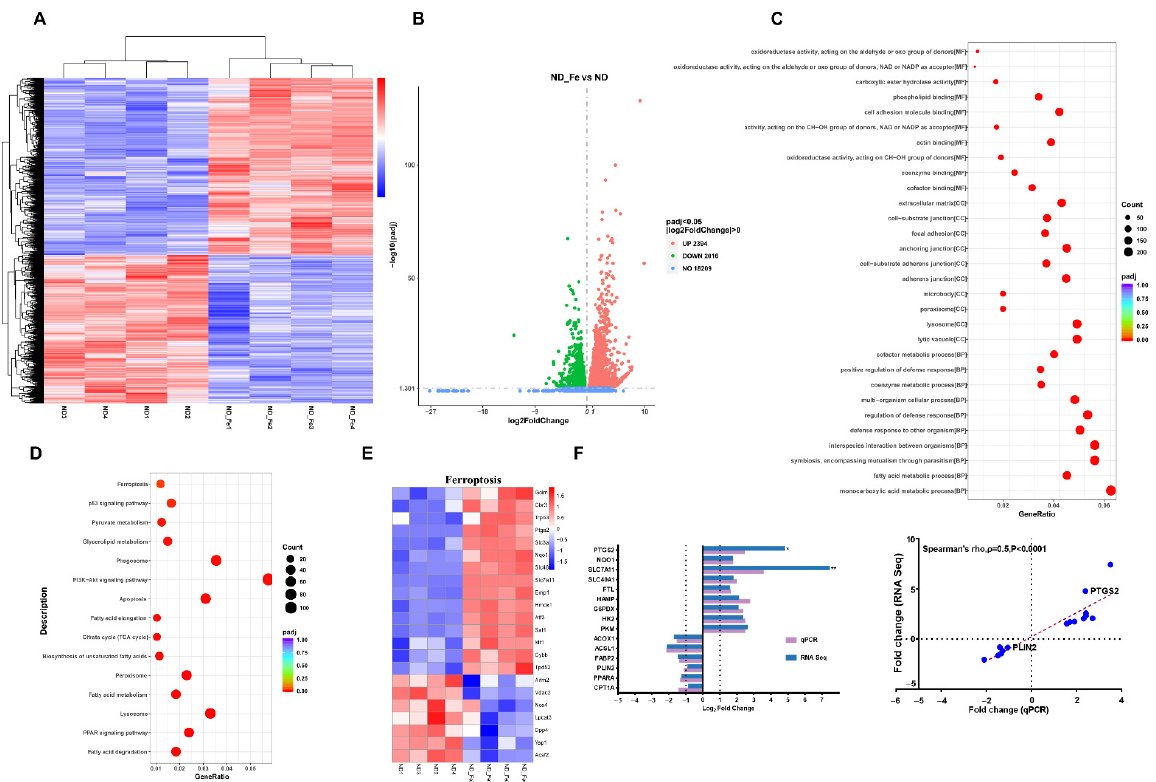
Figure 5. Enriched ferroptosis and fatty acid metabolism pathways by excess iron. ( A ) Cluster analysis of differentially expressed genes; ( B ) DEGs among ND and ND + Fe groups were showed by volcanic maps. After log2 conversion, the X-axis represents the difference multiples, and after log10 conversion, the Y-axis displays the significant value. (P adj < 0.05 & Abs (Log2 fold change) > 0); ( C , D ) GO functional enrichment analysis and KEGG pathway enrichment are shown in a bubble diagram; ( E ) Heatmap showing relative expression of chosen ferroptosis regulated genes from DEGs. Only genes with P < 0.05 are shown; ( F ) qPCR validation of RNA-seq findings and correlation analysis of RNA-seq and qPCR. Expression profiles of RNA-seq data and qPCR data of chosen genes were compared within the same samples. The results are provided as Log2 values of the fold change and represent mean values. ND ( n = 4), ND + Fe ( n = 4).